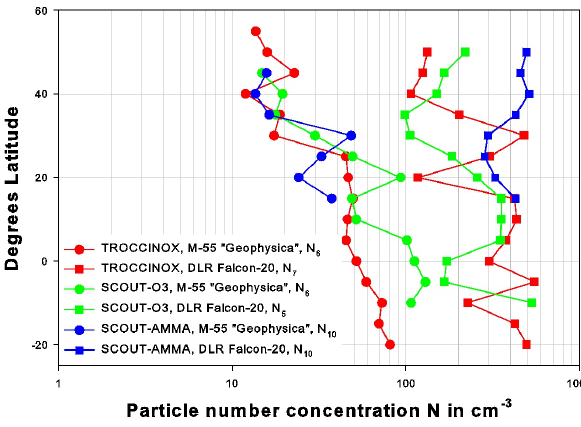
Fig. 3. Summary of the submicron particle concentration latitude profile data of Fig. 2 from the transfers of the DLR Falcon-20 and the M-55 “Geophysica” between Europe and Brazil, Australia, West Africa in 2005 and